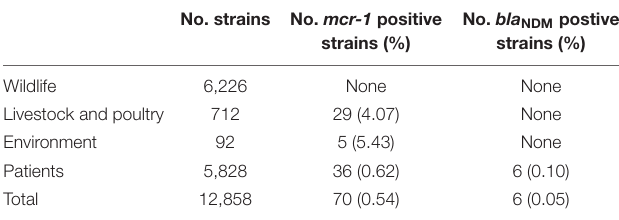
( Table 4 ). Six strains with bla NDM were sensitive to polymyxins ( Figure 3 ). The sensitivity data for all strains referred to Supplementary Table S1